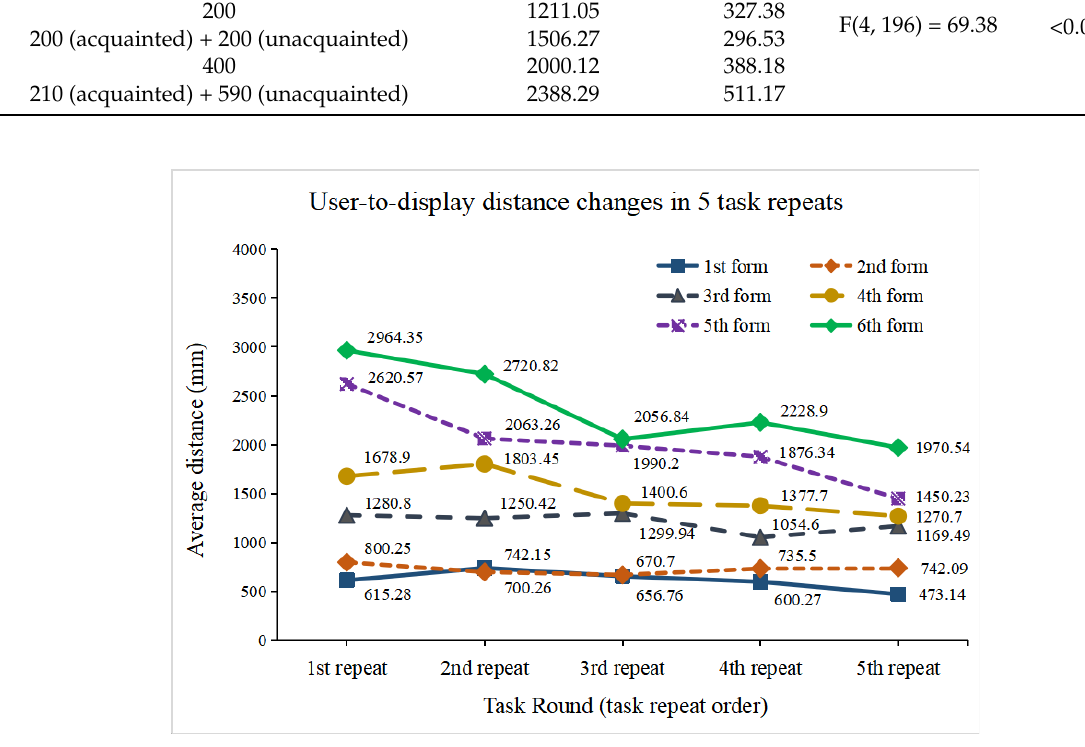
Table 3. A statistical result of the interpersonal proximity in group forms 2 to 6. Group